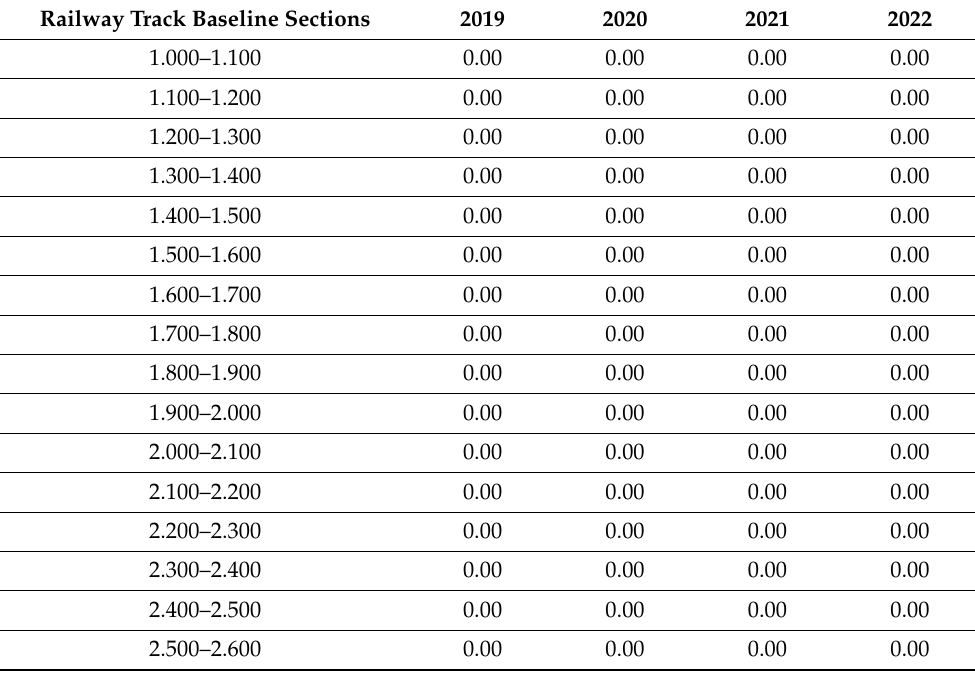
Table A7. Estimates of the railway track condition—relative D 5 object No. R 143_1_2. Railway Track Baseline Sections